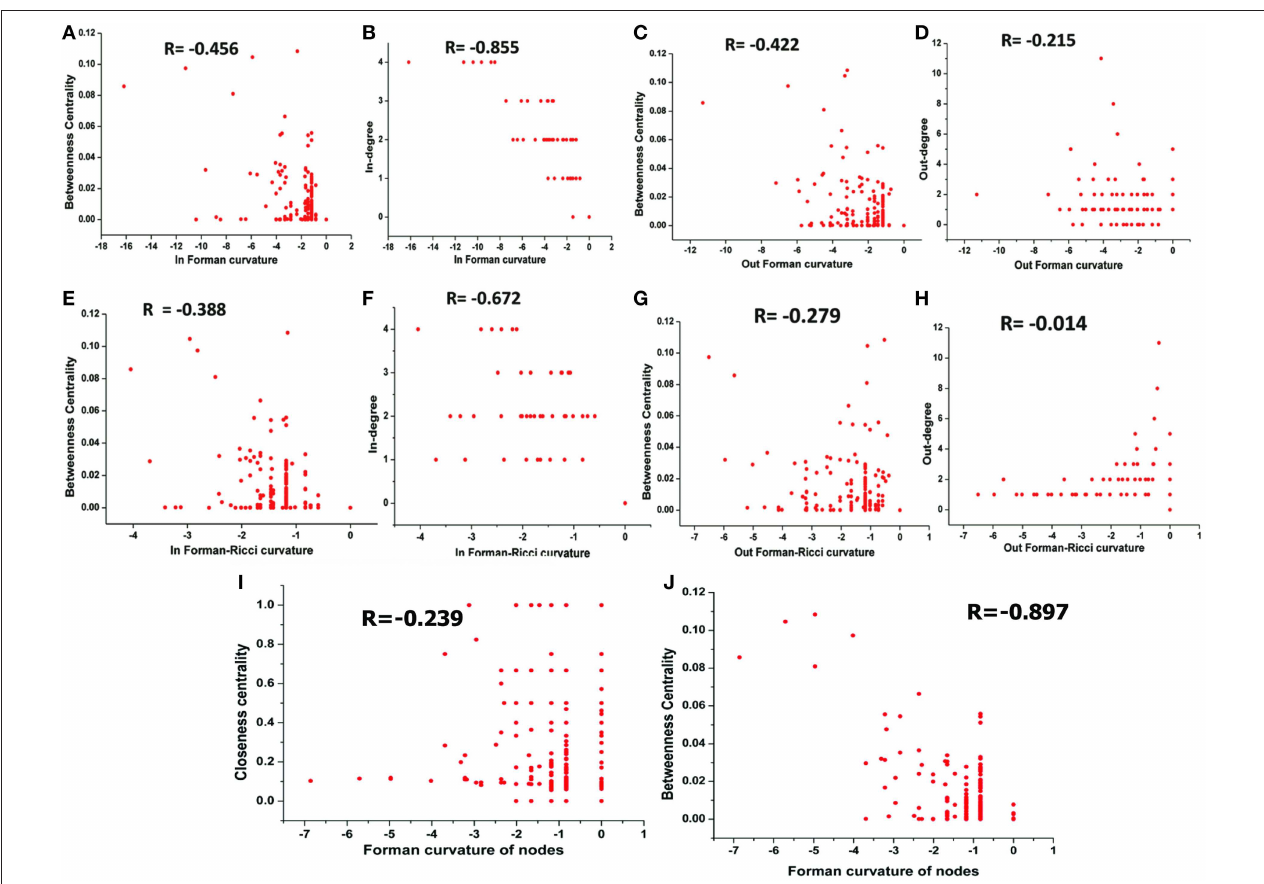
FIGURE 6 | Correlation between (A) Fi-Betweenness centrality; (B) Fi-In-degree; (C) Fo-Betweenness centrality; (D) Fo-Out-degree; (E) FRi-Betweenness centrality; (F) FRi-In-degree; (G) FRo-Betweenness centrality; (H) FRo-Out-degree; (I) Fv-Closeness Centrality; and (J) Fv-Betweenness Centrality of nodes in Master “M” network. Also, Spearman correlation coefficient is indicated for